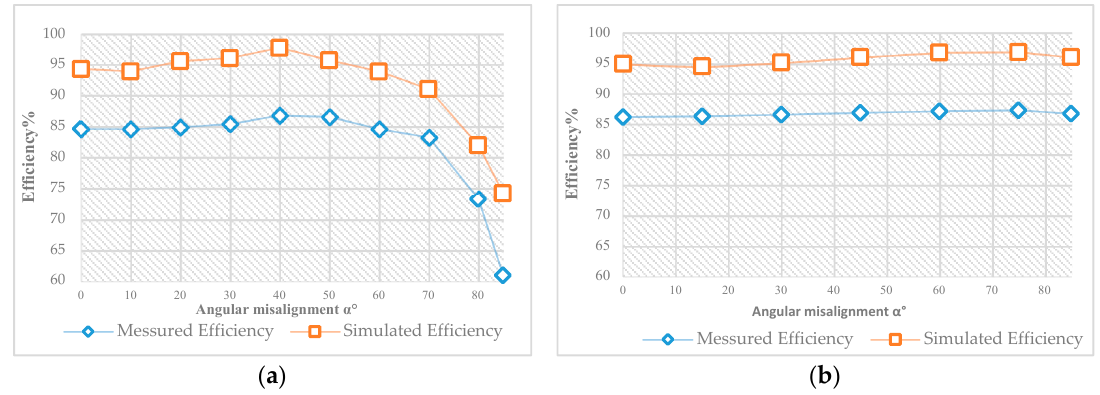
Figure 21. Efficiency: ( a ) double-layer windings; ( b ) optimal model.